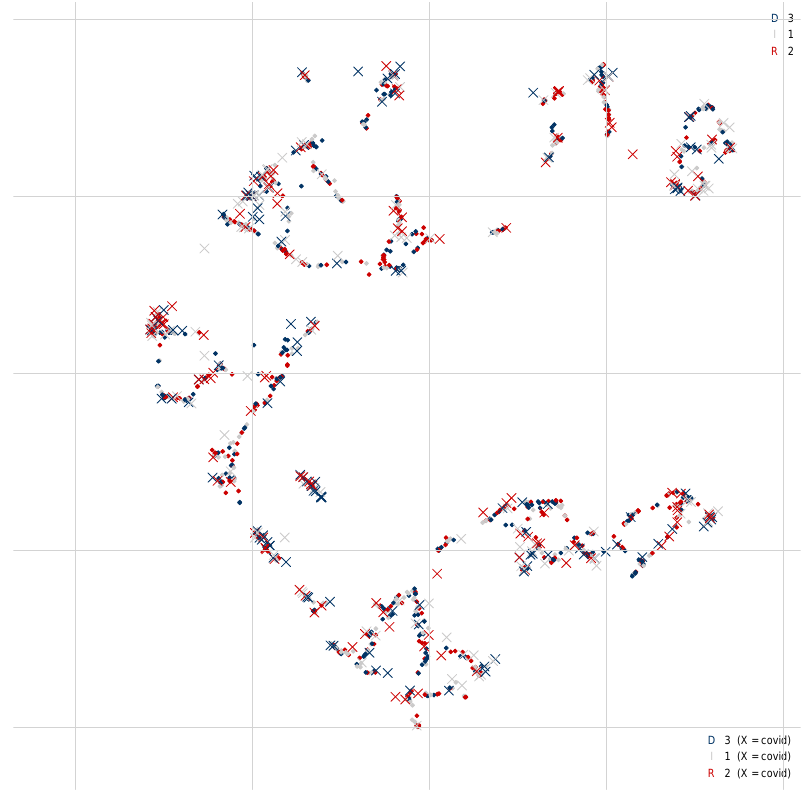
Fig. 5 Projecting COVID onto pre-COVID period: Addressing time-related